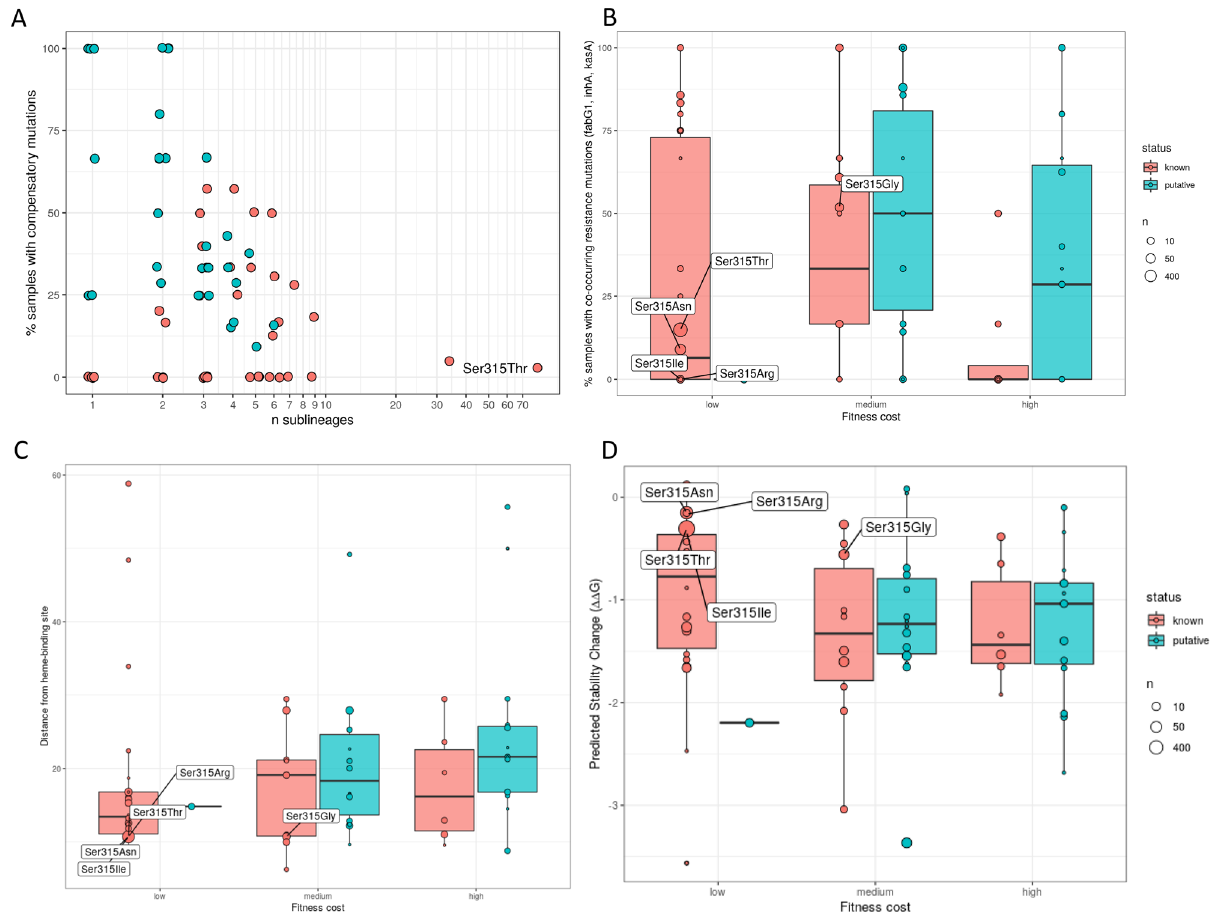
Figure 3. Comparison of mutation characteristics between putative and known resistance mutations. A) For each resistance mutation, the percentage of samples with a co-occurring compensatory mutation is plotted against the total number of sub-lineages it occurs in. B) Boxplot showing the percentage co-occurrence with other resistance mutations grouped by the discretised fitness categories (see Methods). Bottom boxplots show C) distance from INH heme binding site, and D) stability change distributions, grouped by the fitness